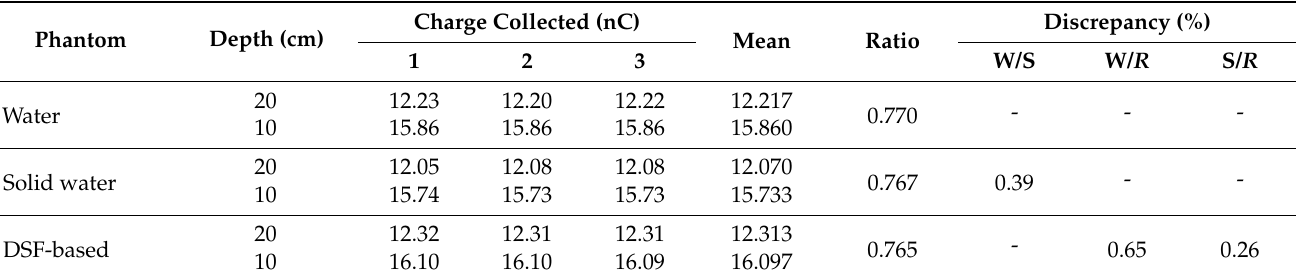
Table 7. TPR 20,10 evaluation for DSF/NaOH/IA-PAE/ R. spp. particleboards (sample A 15 ), water, and solid water phantoms for 10 MV photons.